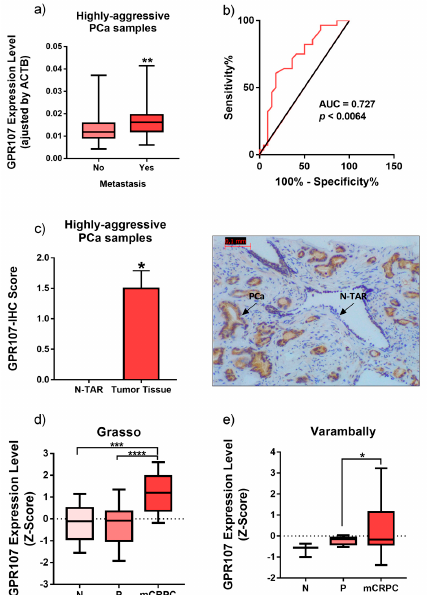
Figure 2. Expression levels of G protein-coupled receptor 107 (GPR107) in primary prostate cancer samples from patients with metastasis. ( a ) Association between GPR107 expression levels and the presence of metastasis in a cohort of fresh samples from patients with Prostate Cancer (PCa) n = 67). ( b ) Operating characteristic (ROC) curve analysis to determine the accuracy of GPR107 to discriminate between metastatic vs. non-metastatic patients’ tumor. ( c ) Comparison of GPR107 protein level by Immunohistochemistry (IHC) between primary PCa samples from patients with metastasis and its non-tumor adjacent regions (N-TAR). Messenger RNA (mRNA) levels were determined by quantitative Polymerase Chain Reaction (qPCR) and adjusted by Actin Beta (ACTB) expression levels. ( d - e ) Comparison of GPR107 expression levels between normal prostate ( n ), primary prostate tumor (P) and metastatic Castration Resistant Prostate Cancer (mCRPC) samples obtained from two in silico databases (Grasso / Varambally; ( d ) and ( e ), respectively). Asterisks (* p < 0.05; ** p < 0.01; *** p < 0.001; **** p < 0.0001) indicate statistically significant di ff erences between groups. AUC: Area Under the